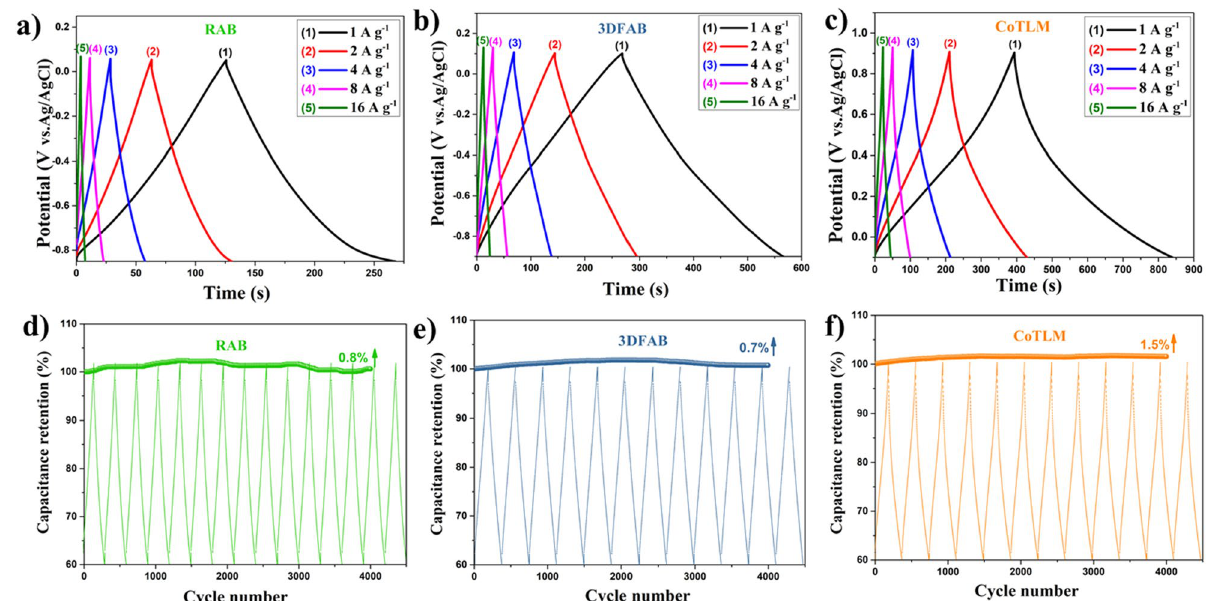
Figure 7. GCD of RAB, 3DFAB, and CoTLM at the current densities rates from 1 to 16 A g −1 ( a – c ); and cyclic performance of the RAB, 3DFAB, and CoTLM electrodes at the current density of 4 A g −1 ( d – f ).